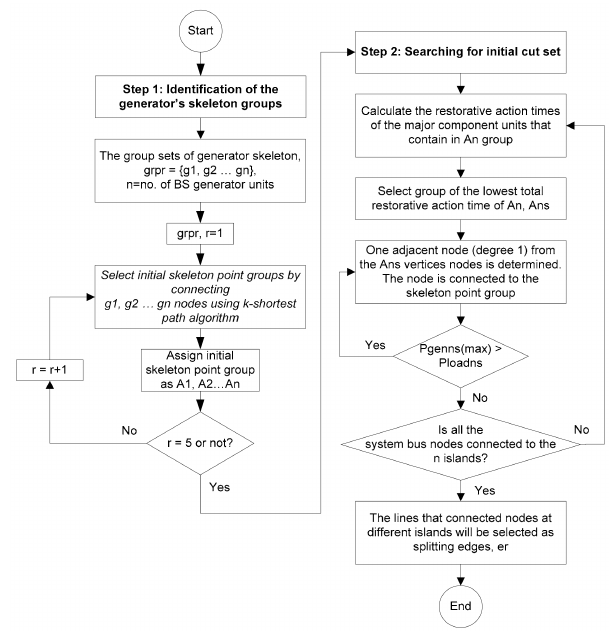
Figure 2. Heuristic